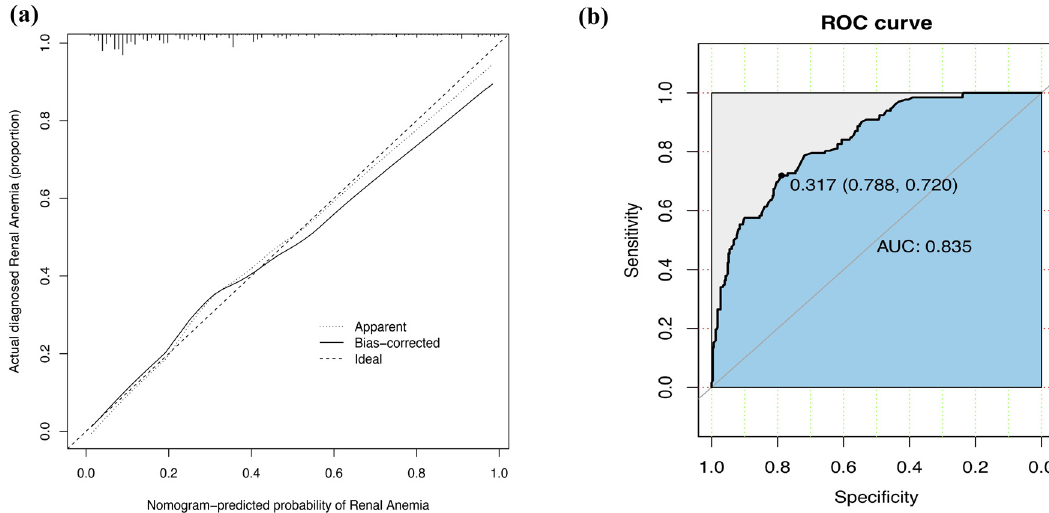
Figure 3: Calibration curve and ROC curve for the renal anaemia nomogram prediction in the cohort. ( a ) Calibration curve. The x - axis represents the predicted renal anaemia risk. The y - axis represents the actual diagnosed renal anaemia. The diagonal dotted line represents a perfect prediction by an ideal model. The solid line represents the performance of the nomogram, of which a closer fi t to the diagonal dotted line represents a better prediction. ( b ) ROC curve. It showed that the AUC of this model for predicting renal anaemia was 0.835. The optimal cut - o ff value of the ROC curve was 0.317, corresponding to a speci fi city and sensitivity of 0.788 and 0.720, respectively. Abbreviations: ROC curve, receiver operating characteristic curve; AUC, area under the